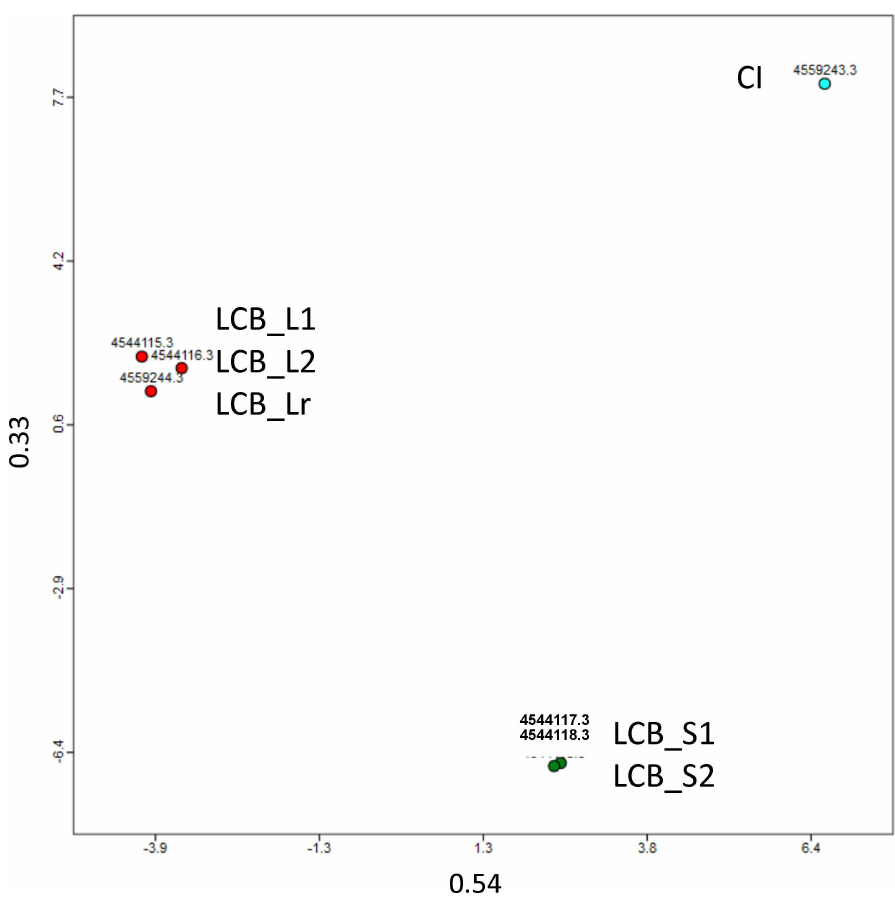
Fig 2. Principal component analysis of original compost metagenome CI (blue), LCB_S1, LCB_S2 (green), LCB_L1, LCB_L2 and LCB_Lr metagenomes (red), realized with MG-RAST. The two componentsrepresentedexplainabout 90% of the difference betweenthe